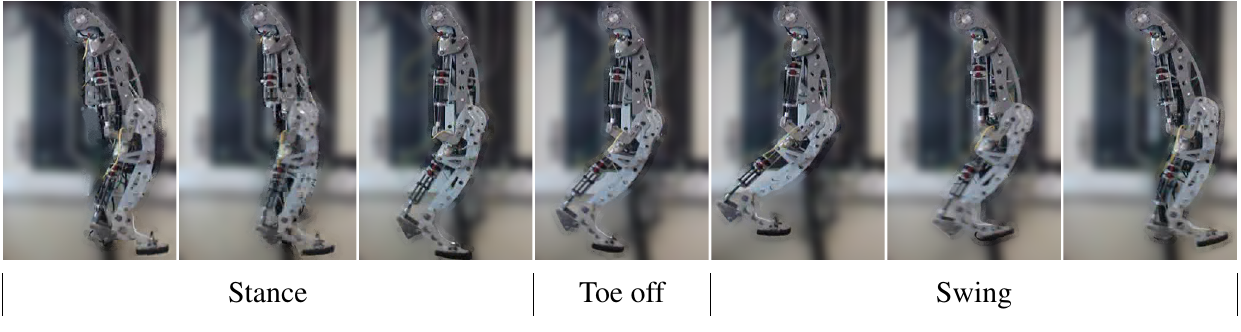
Figure 24. Sequence of the locomotion cycle of the HADE